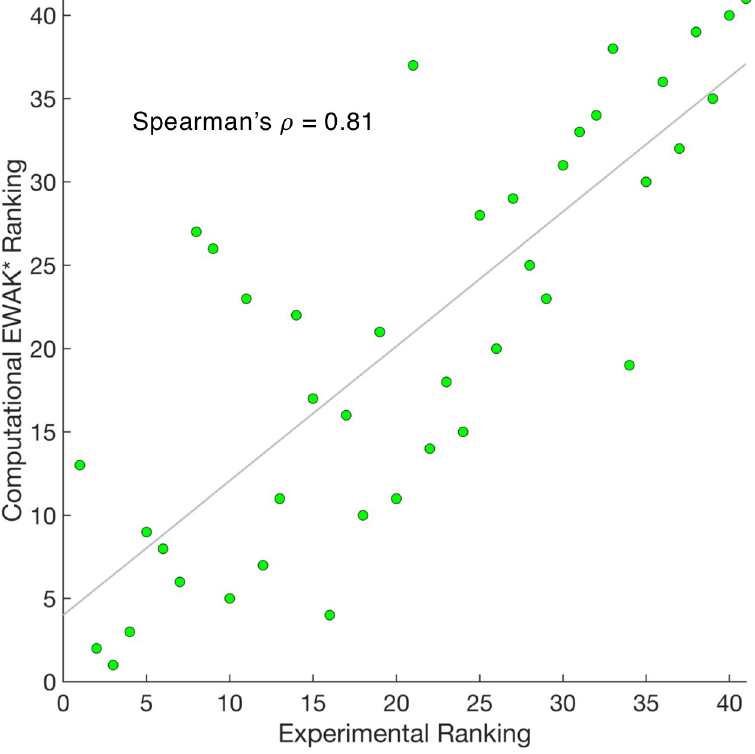
Fig 6. Comparing the computational EWAK � ranking with the experimental ranking for 41 c-Raf-RBD variants binding to KRas. Each green dot represents a variant of c-Raf-RBD and is plotted according to the experimental ranking along with the corresponding computational ranking of its binding to KRas. A least squares fit line is shown in gray. Calculating the Pearson correlation coefficient between the two sets of rankings yields a Spearman’s ρ of